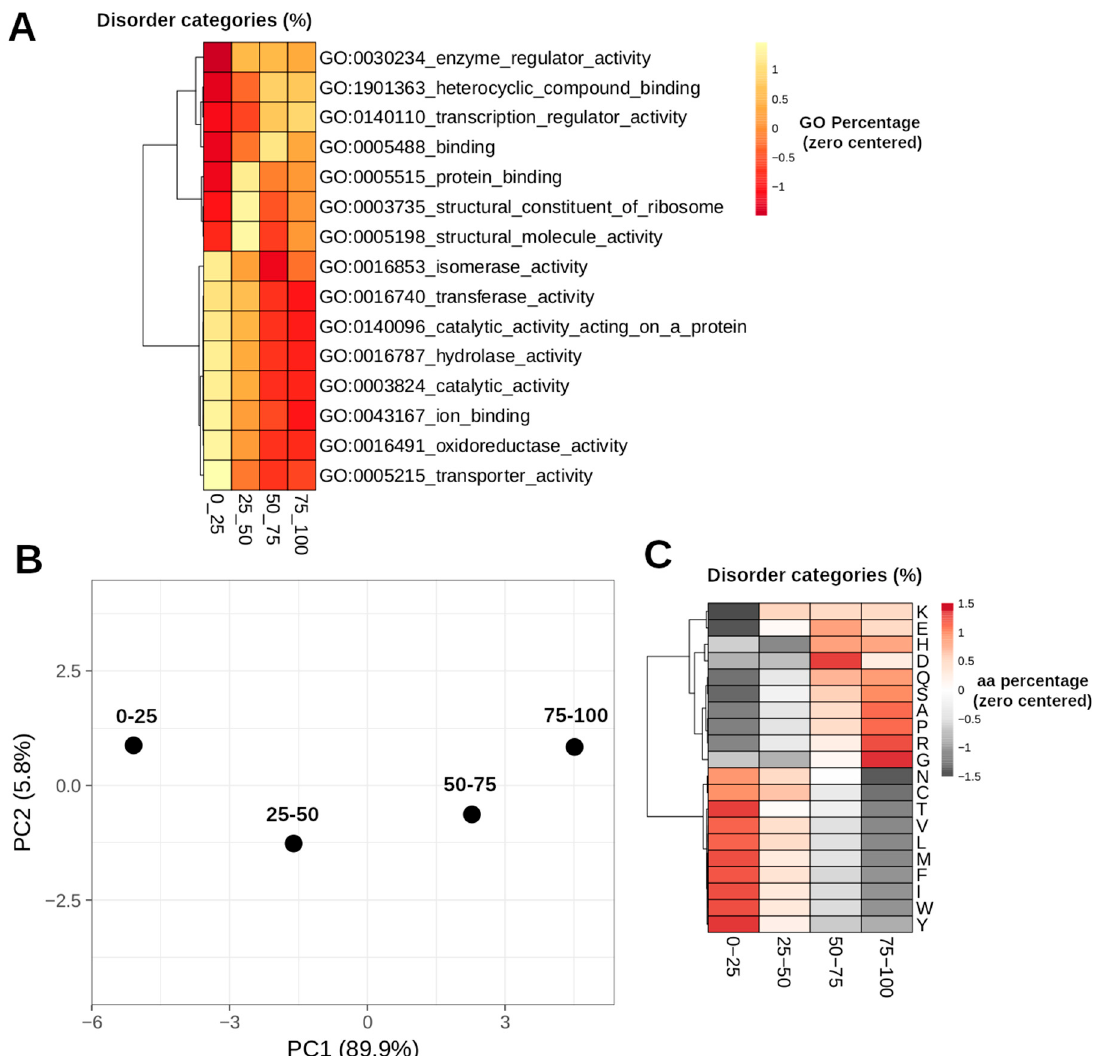
Figure 2. General characteristics of the proteins according to the disorder content of each category defined in this work. A) Heatmap of the enriched Gene Ontology (GO) terms between the four defined categories for a p -value < 0.01. Colors represent the percentage of each GO category with scaling applied to rows and the values centered to zero. B) Principal Component Analysis (PCA) analysis of the aa composition of the proteins that constitute each category. Unit variance scaling is applied to relative aa composition of the proteins of each category; Singular Value Decomposition (SVD) with imputation is used to calculate principal components. X and Y axis show principal component 1 and principal component 2 which explain 89.9% and 5.8% of the total variance, respectively. C) Heatmap of the aa composition of the different categories of protein disorder. The rows were centered, and scaling was applied. The rows were then clustered using correlation distance and complete linkage.